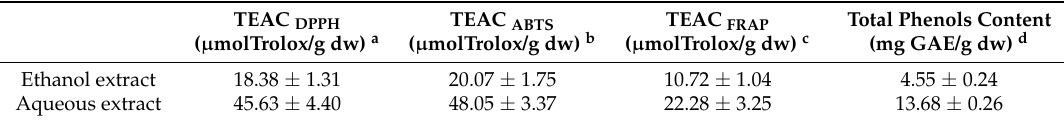
Table 6. Antioxidant capacity and total phenols in ethanol and aqueous extracts obtained from wild L. deliciosus .